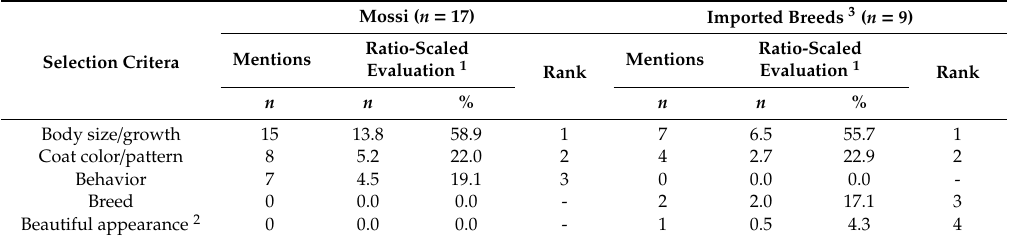
Table 8. Criteria used to select local and imported rams for replacement (sheep breeders n = 26). Mossi ( n = 17) Selection Critera Body size /